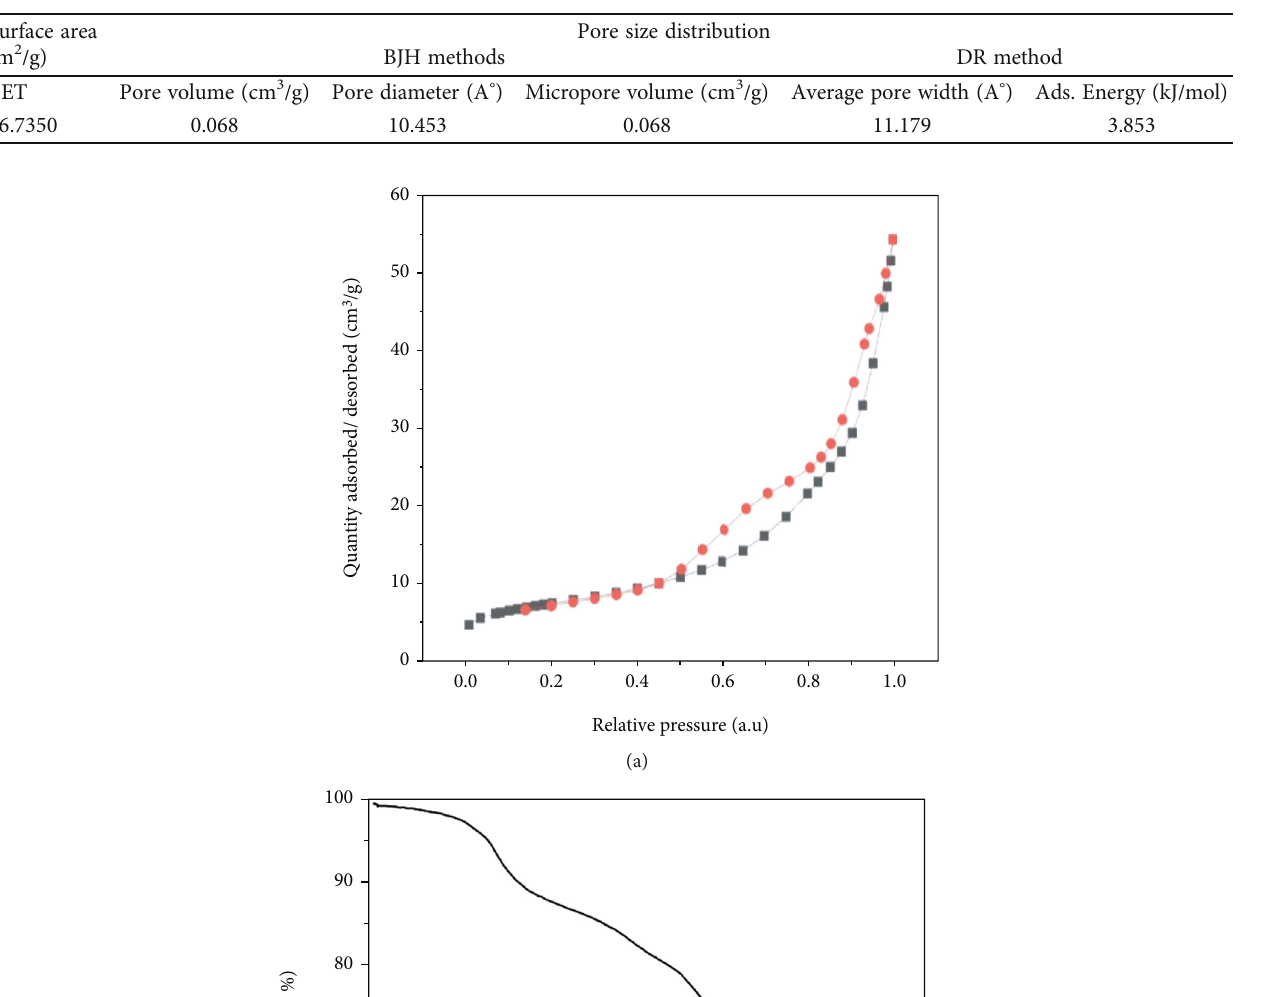
Table 2: Surface area and pore size distribution of hydrogel